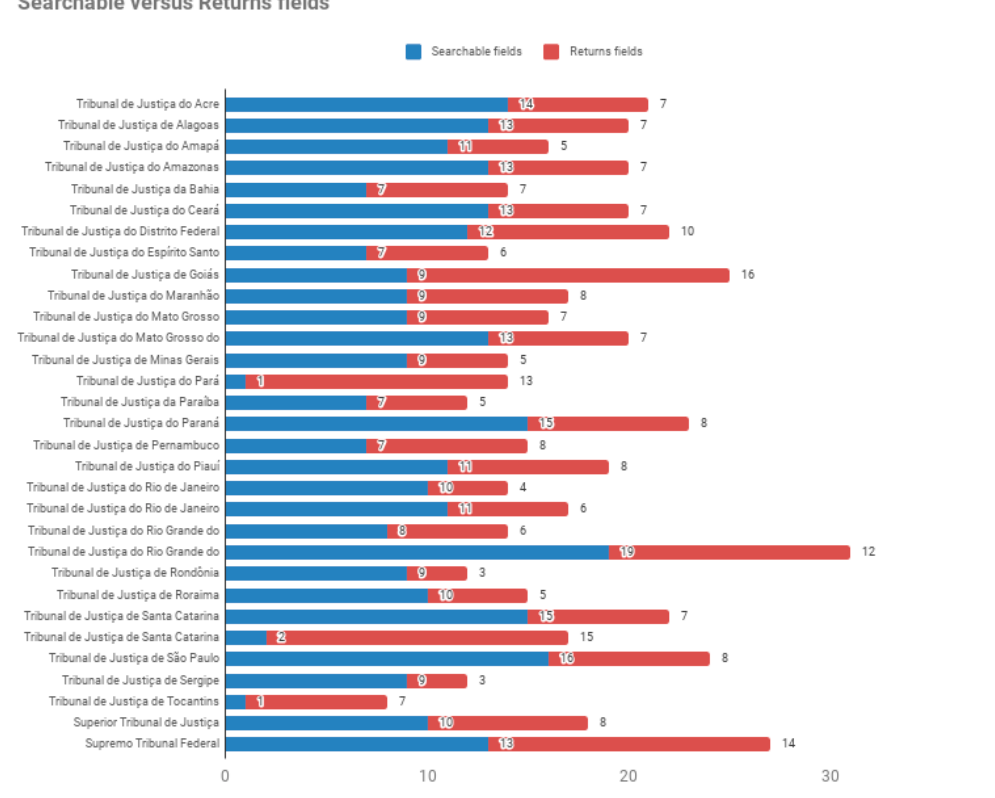
Figure 2. Number of fields available in the search engine per court and corresponding number of attributes shown in results.